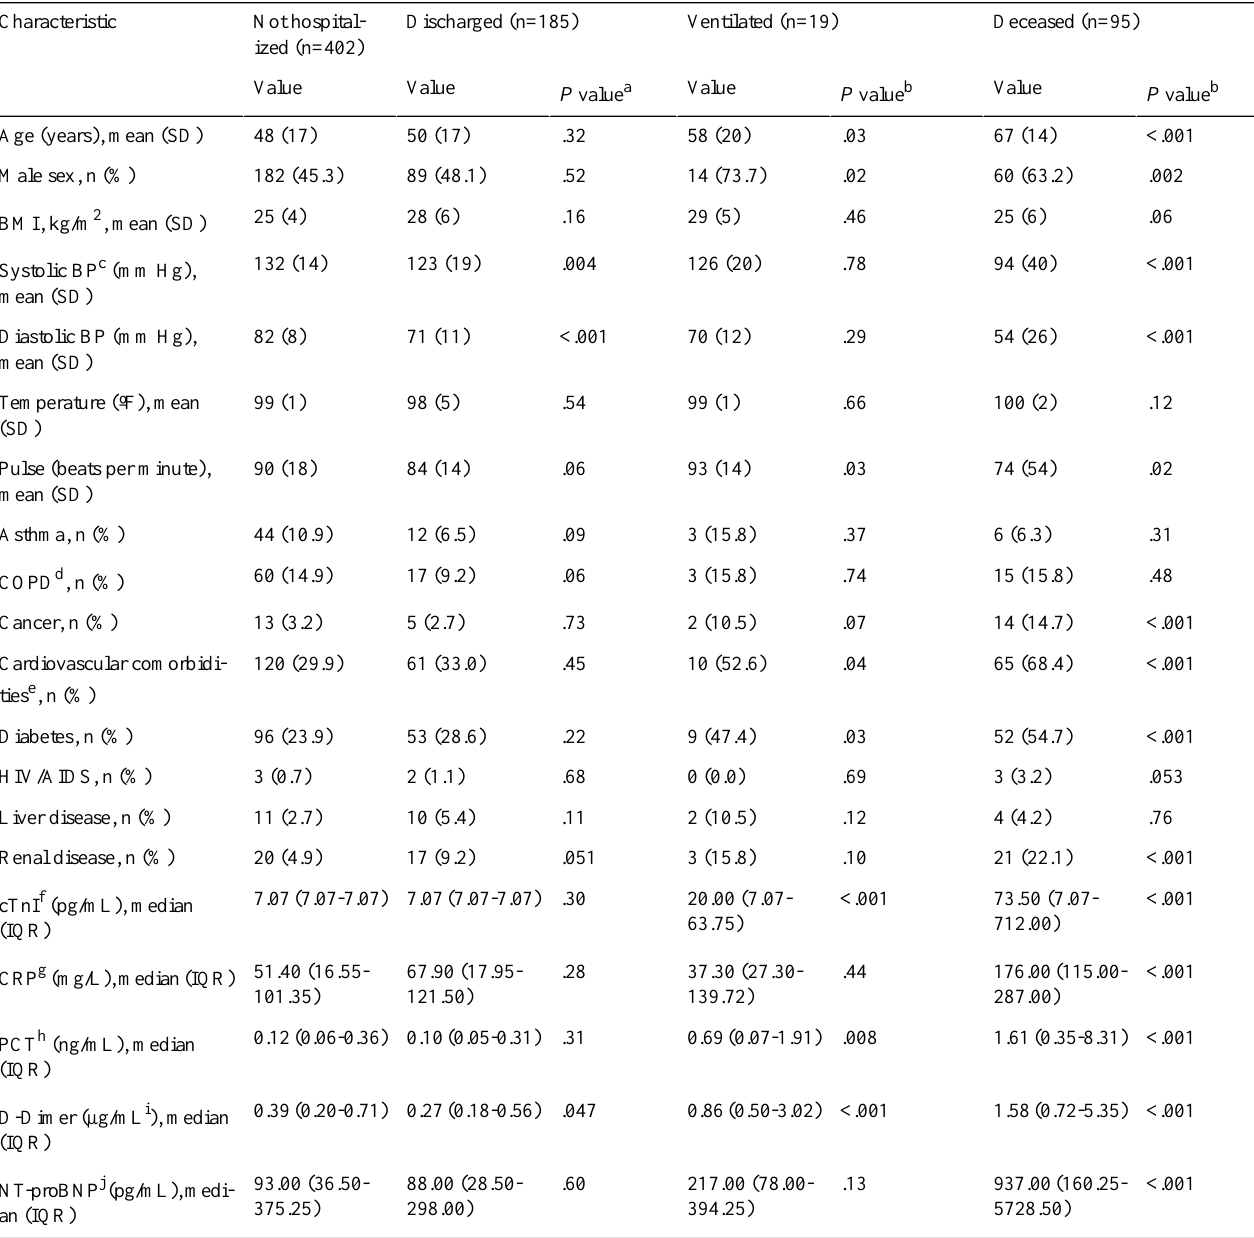
Table 1. Characteristics of the patients included in model training. Data are represented as n (%), mean ± standard deviation, or median